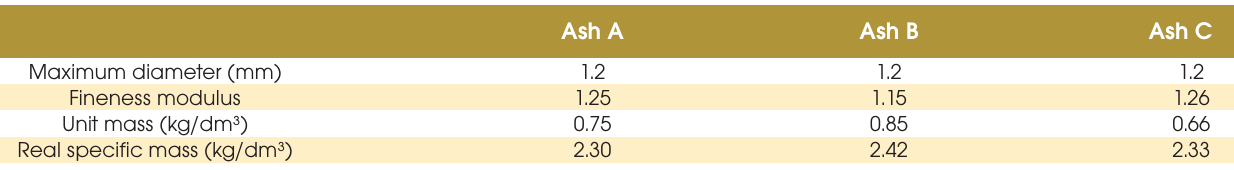
Table 3 – Particle size characteristics and specific masses of ash varieties